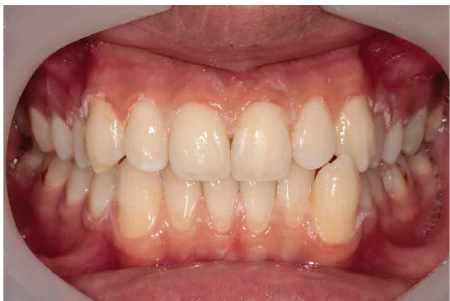
Figure 5: Teeth after the treatment at the follow-up session 6months after the initial